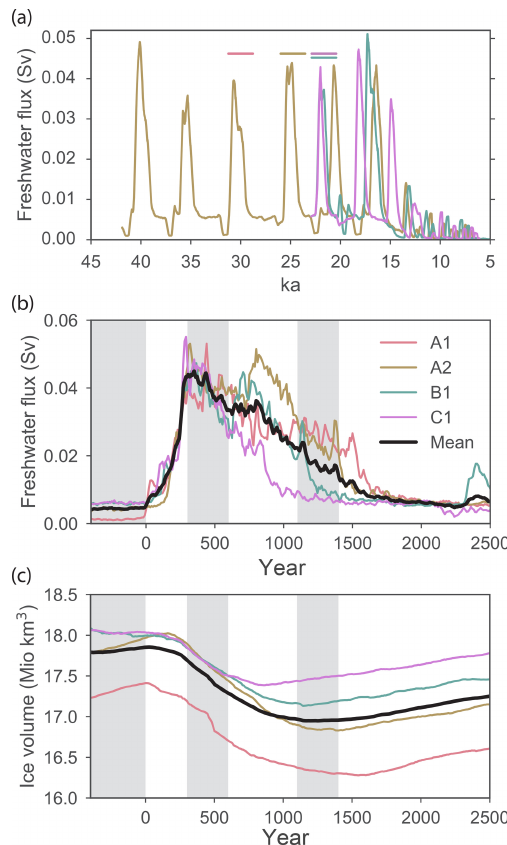
Figure 1. (a, b) Hudson Strait ice stream discharge; (c) ice volume of the eastern part of the Laurentide Ice Sheet. Panel (a) is aver- aged over 300 years, panel (b) is averaged over 30 years, and panel (c) is plotted from instantaneous values. Line colors in (a) corre- spond to Heinrich events A2, B1, and C1, and horizontal bars mark the events selected for the composite analysis in the colors used throughout the time series analysis. The vertical gray bars in (b) and (c) mark the pre-surge (years − 400 to 0), surge (years 300 to 600), and post-surge (years 1100 to 1400) phases (Sect. 2.3). 1Miokm 3 of ice corresponds to about 2.5m of sea